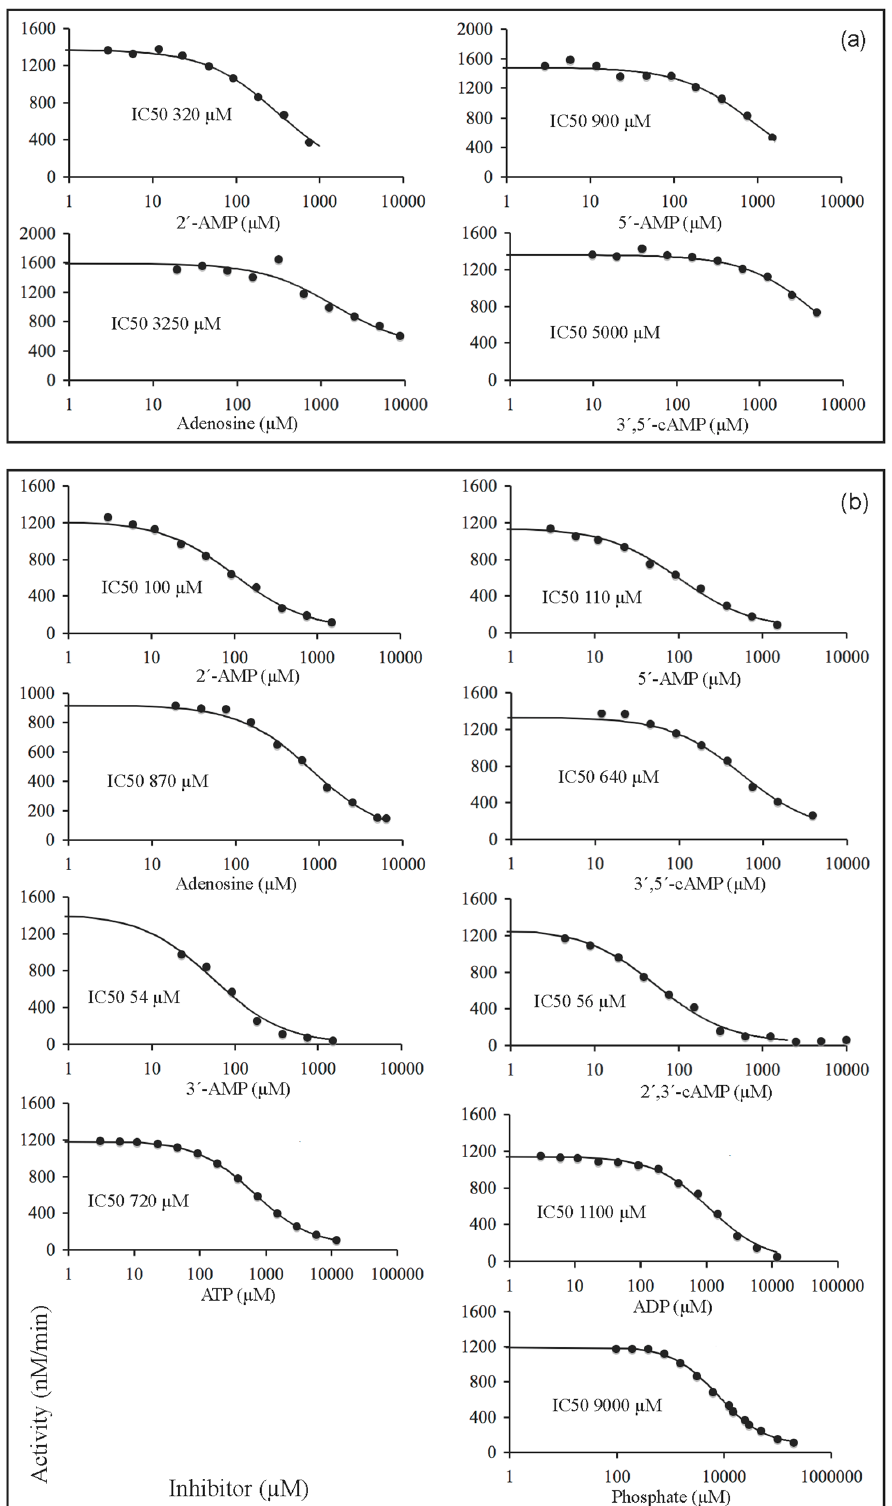
Figure 4. Inhibitor dose-response curves of mature CpdB. IC50 is the inhibitor concentration causing 50% inhibition for each particular substrate-inhibitor combination. The panels are single illustrative experiments. ( a ) Curves were recorded with 370 µM 3 ′ -AMP as the substrate. ( b ) Curves were recorded with 750 µ M bis-4-NPP as the substrate. The curves were obtained by fitting the equation for a mixed partial inhibition to the experimental data, as in Figure